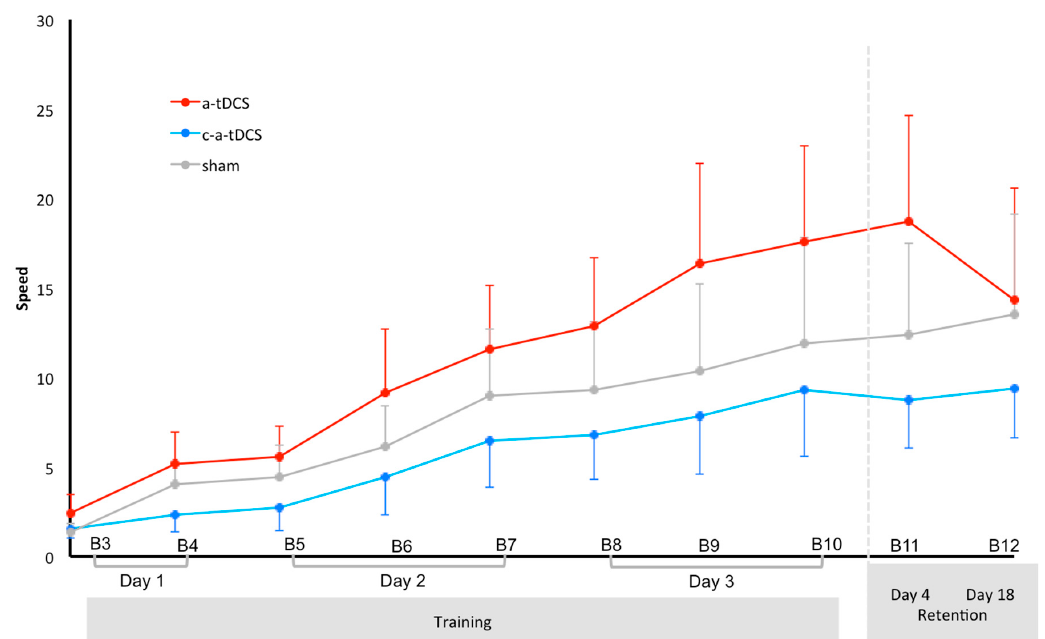
Figure 5. Evolution of of mean (and one SEM) speed over time (blocks—B) for each of the 3 groups. B3, B6 and B9 represent online tDCS. B3, B6 and B9 represent online tDCS. B4, B7 and B10 represent immediate offline. B5 and B8 represent delayed offline.